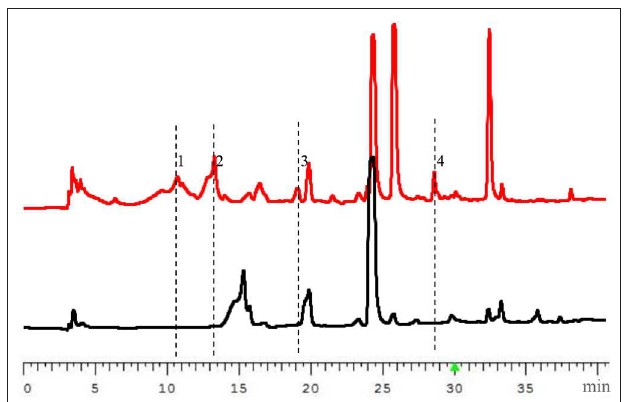
FIGURE 1 | HPLC profiles of the extracts from wild type (WT, the lower diagram) and OE::PbrlaeA (MT, the upper diagram) strains of P. brocae HDN-12-143 (220nm).